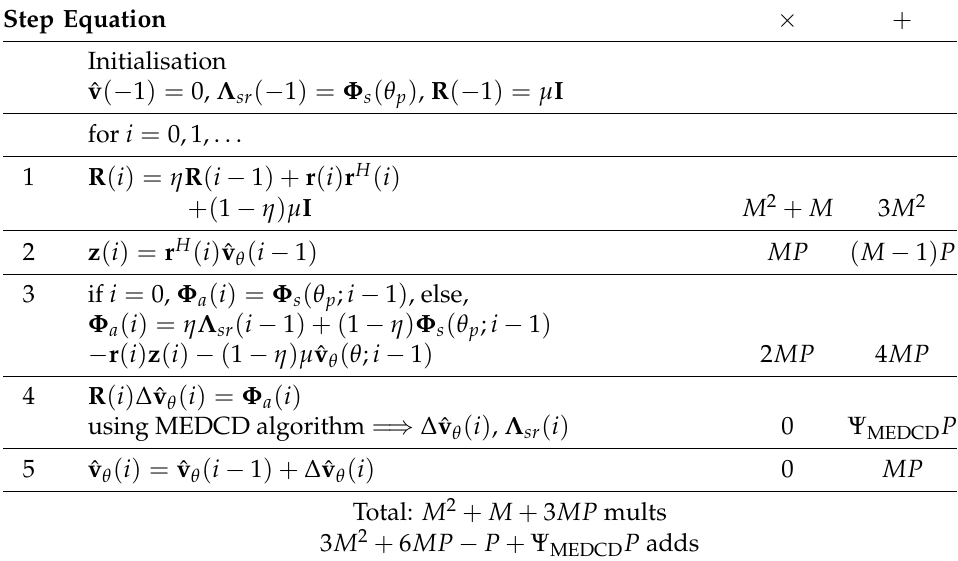
Table 2. Diagonally loaded MEDCD-RLS-MVDR DoA estimator ( M